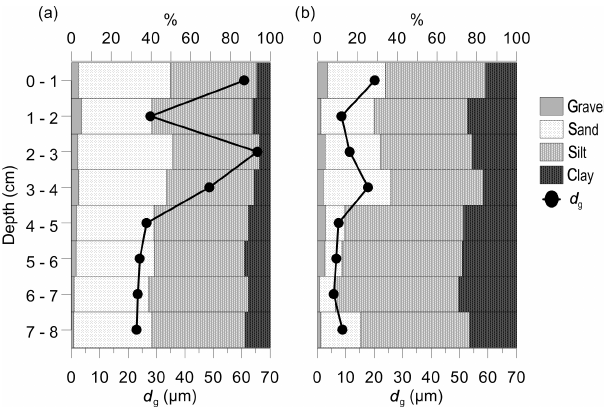
Figure 5. Granulometric composition and median grain size ( d g ) of vegetated (a) and nonvegetated sediment (b)